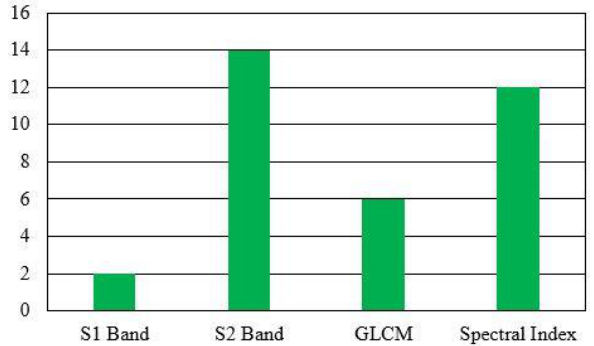
Figure 3. Number of input variables generated by the MDA FS method and grouped by the source of the input